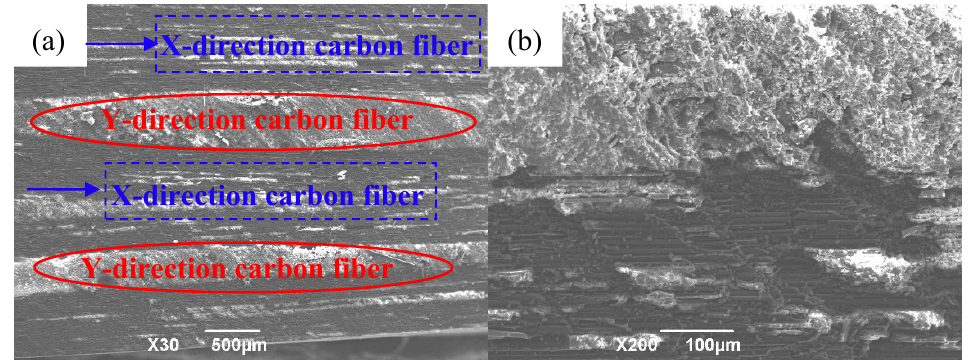
Figure 9. Infiltration microstructure of 2D-CFRP composite: ( a ) Infiltration microstructure of 2D-CFRP ( × 30); ( b ) infiltration microstructure of 2D-CFRP ( ×